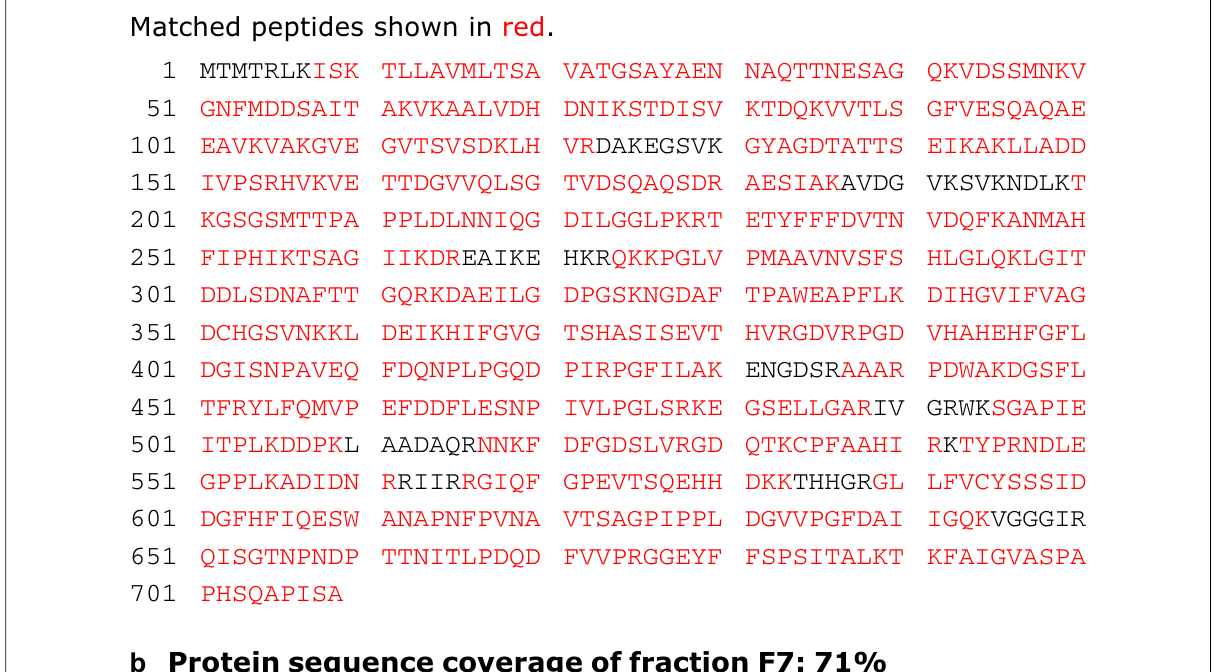
b Protein sequence coverage of fraction F7: 71% Matched peptides shown in red.